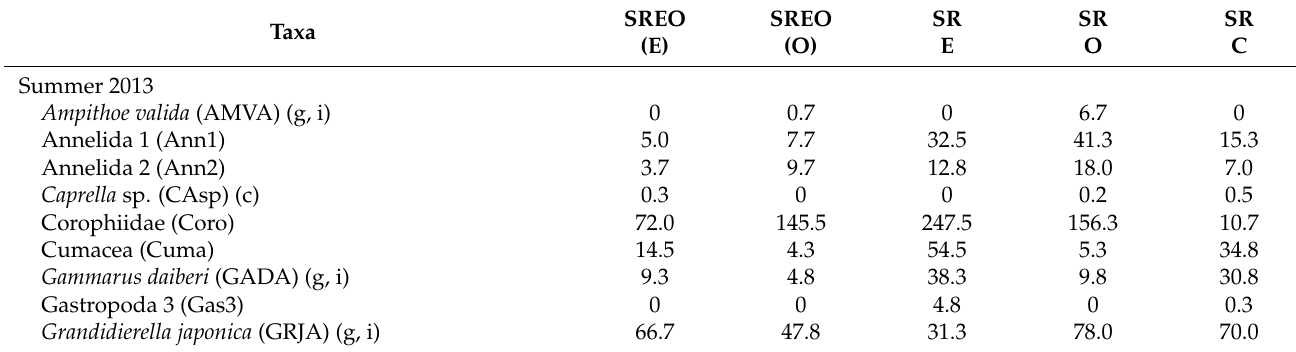
Table A2. Suction-sampled invertebrate community composition and mean abundance per sample in the post-treatment sampling periods. Letters represent family and order (c = caprellid, g = gammarid, I = isopod), and native (n), introduced (i), or cryptogenic (c). See Figure 1 for site